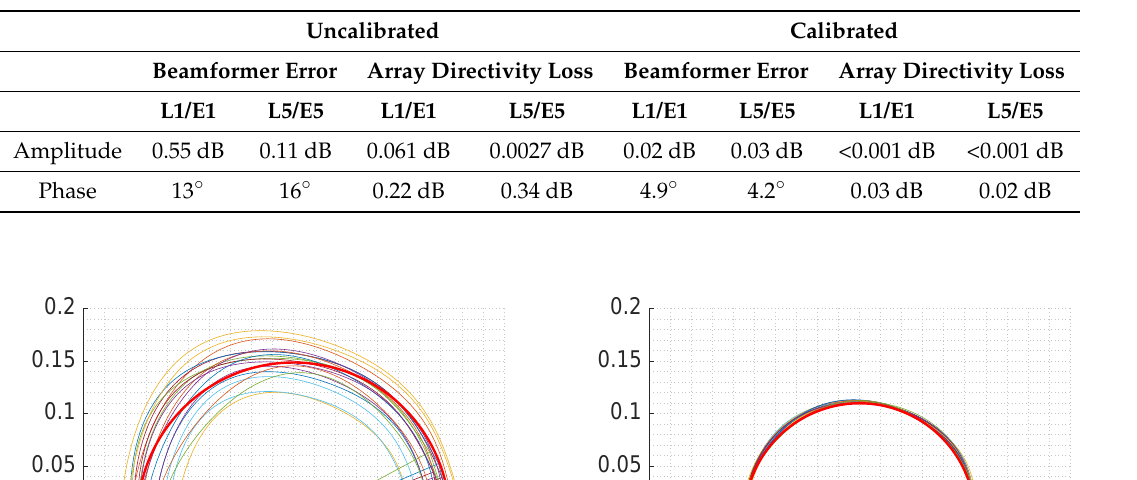
Figure 18. MIR down-looking array being calibrated and measured at the Universitat Politècnica de Catalunya (UPC) anechoic chamber. The 19 elements MIR array is at the back left, while the transmitting reference horn antenna is at the front right. The transmitting antenna has linear polarization and can rotate along the boresight axis. Table 3. Beamformer inaccuracy impact in the array directivity before and after calibration.